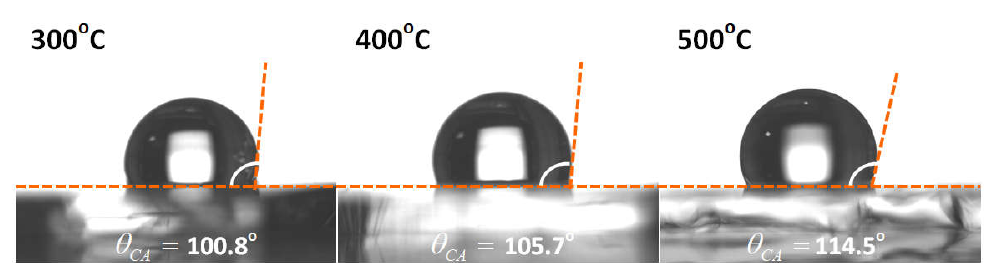
Figure 3. Contact angle images of NiO films surface with water: the substrate temperature of 300 °C, 400 °C, and 500 °C, respectively.